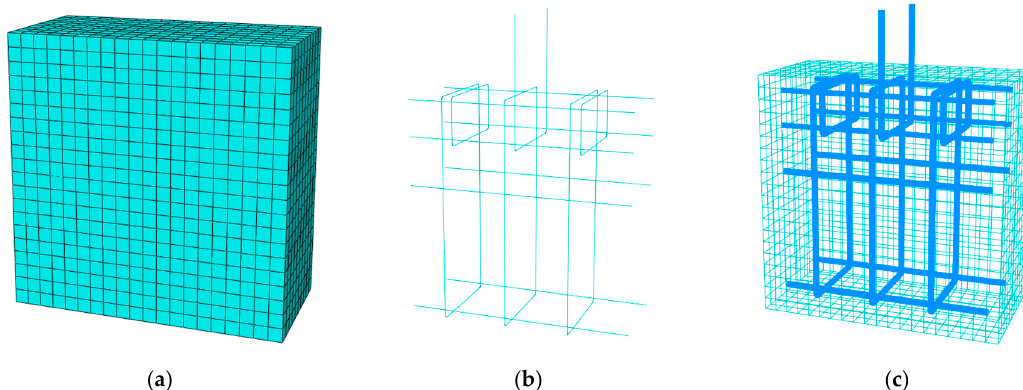
Figure 8. The numerical model. ( a ) Concrete elements; ( b ) Steel elements; ( c ) Perspective of whole model.